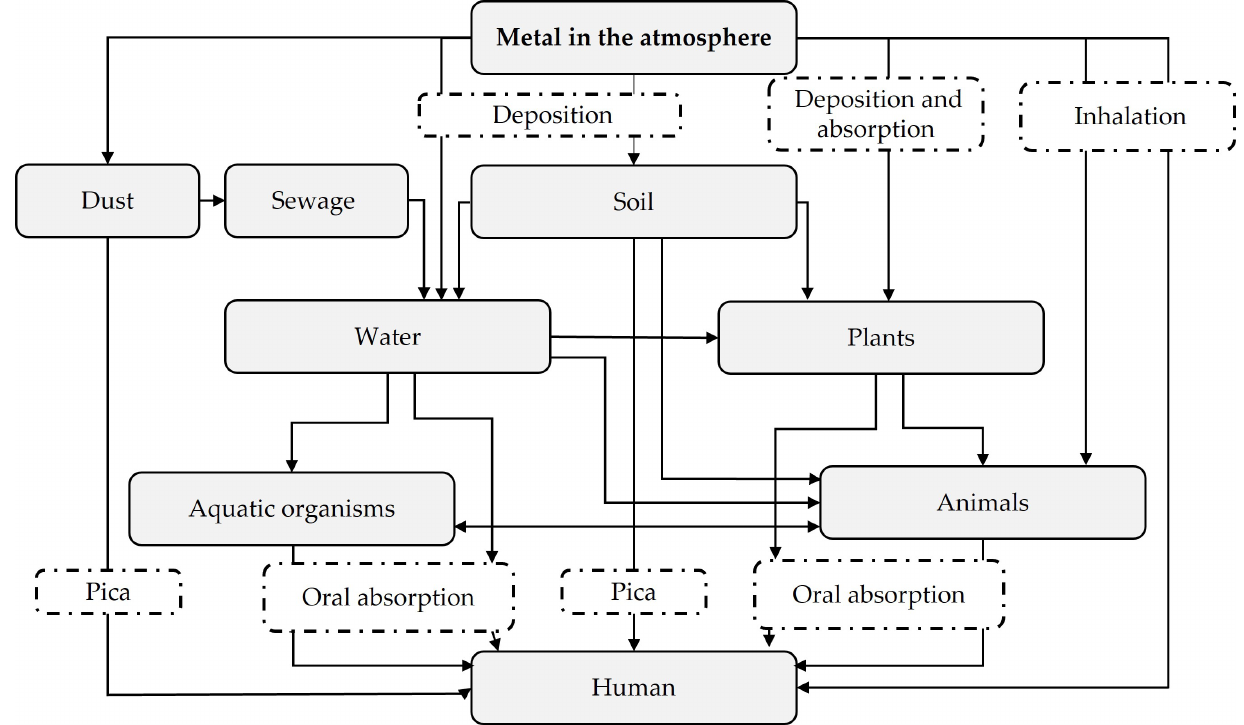
Figure 1. Diagram of environmental exposure and accumulation of metals in the human body, using lead as an example (according to Se´nczuk [50];